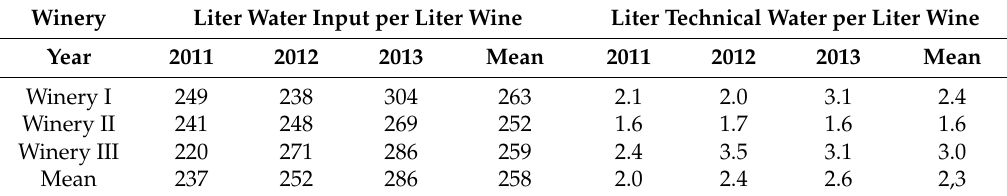
Table 7. Water input per liter of wine.